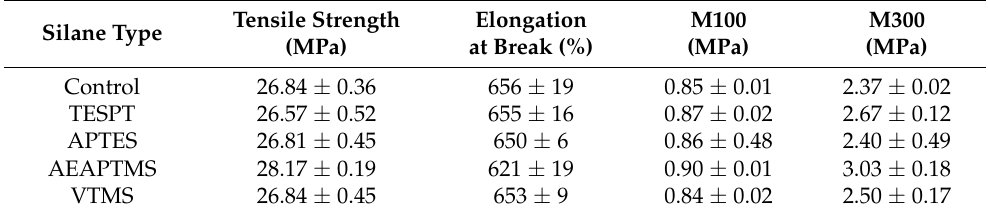
Table 3. Raw data extracted from the rheometric curves of NR/HNT composites filled with and without silane coupling agents.